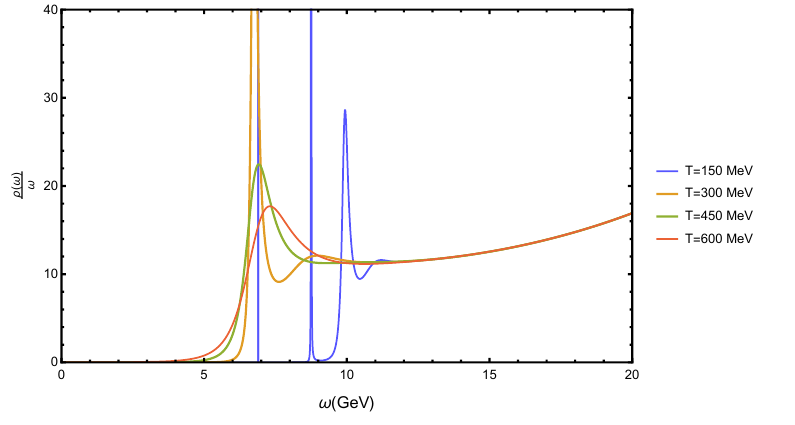
Figure 2 . Spectral function for bottomonium at rest for di(cid:11)erent values of